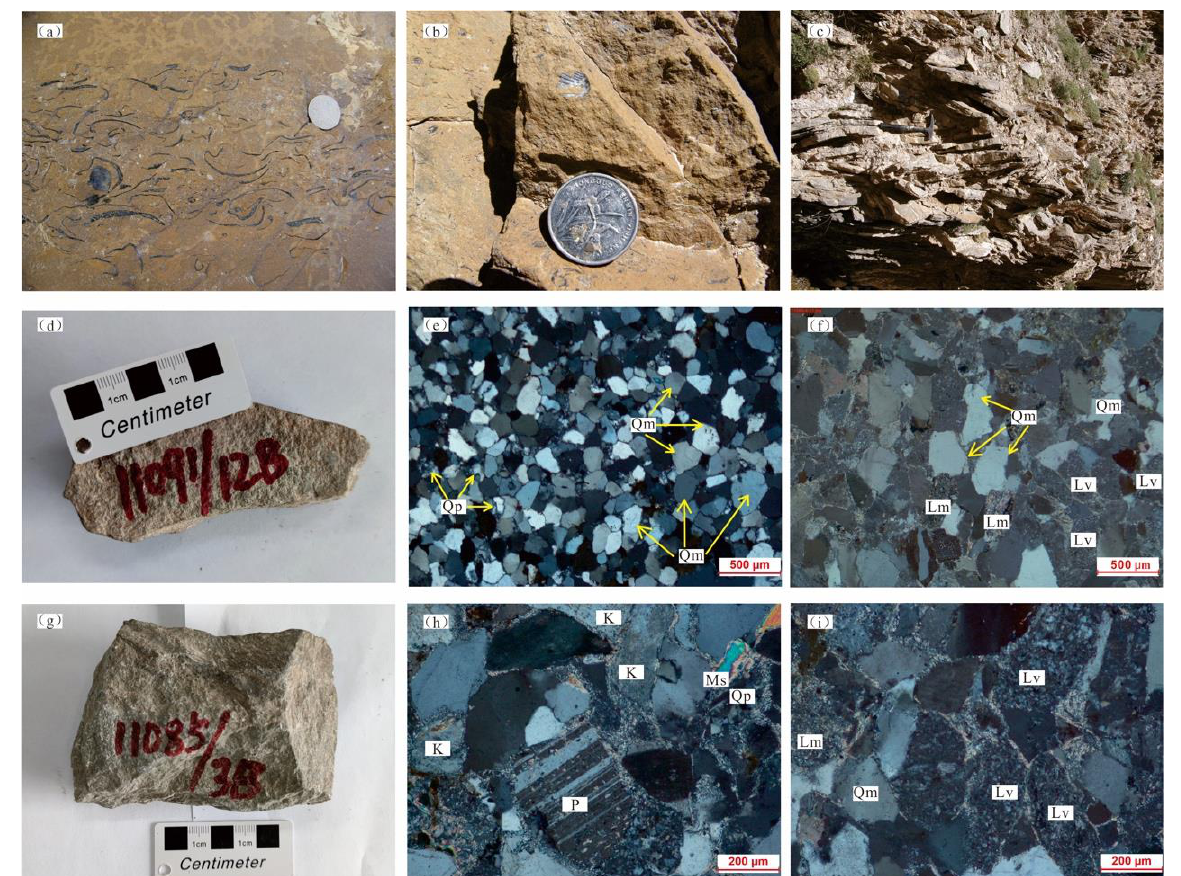
Figure 3. Outcrop, hand specimens, and microscope photographs of the Carboniferous sandstones in the Alake Lake, EKO. ( a ) Lower Carboniferous Halaguole Fm biological shell; ( b ) Lower Carboniferous Halaguole Fm bioclast; ( c ) Lower Carboniferous Halaguole Fm banded limestone; ( d – f ) the hand specimens and microscopic photographs of Lower Carboniferous Halaguole Fm fine sandstone; ( g – i ) the hand specimens and microscopic photographs of Upper Carboniferous to Lower Permain Haoteluowa Fm siltstone; Mineral abbreviations: Qm—monocrystalline quartz; Qp—polycrystalline quartz; K—K-feldspar; P—plagioclase; Lv—volcanic debris; Lm—metamorphic debris;